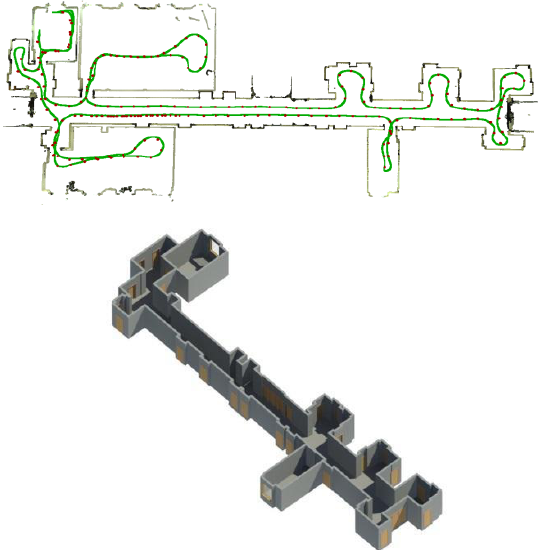
Figure 2. Test area; Top: iMS3D trajectory overlaid on 2D layout of the floor, bottom: 3D model of the test area.